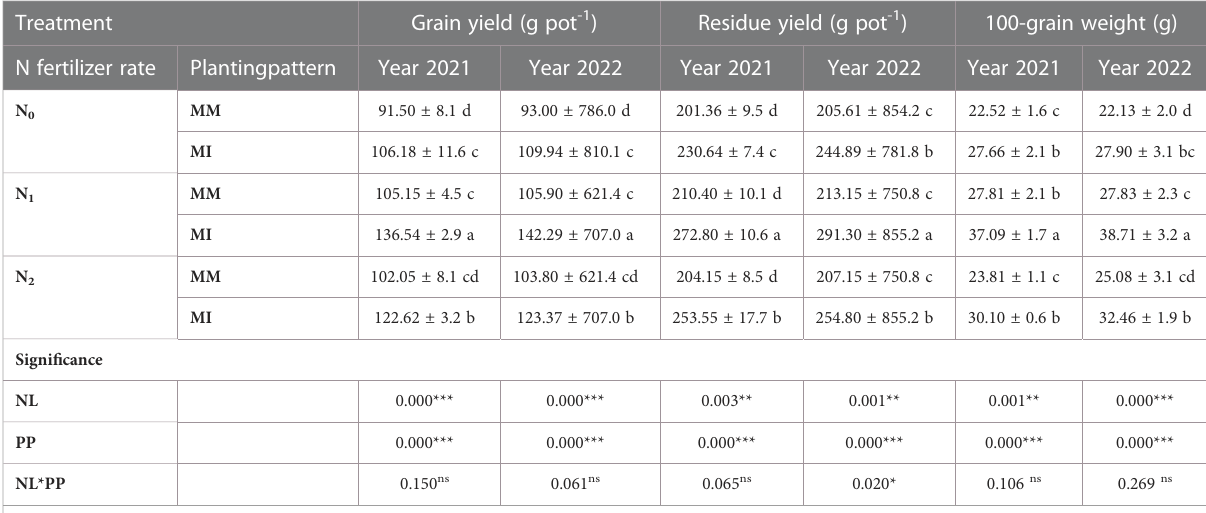
TABLE 1 Grain yield, residue yield and 100-grain weight of maize crop as in fl uenced by different planting patterns (MM, maize mono-cropping and MI, maize intercropping) and N fertilizer application rates (N 0 ; 0 kg N ha -1 , N 1 ; 250 kg N ha -1 and N 2 ; 300 kg N ha -1 ) in 2021 and 2022 crop growing